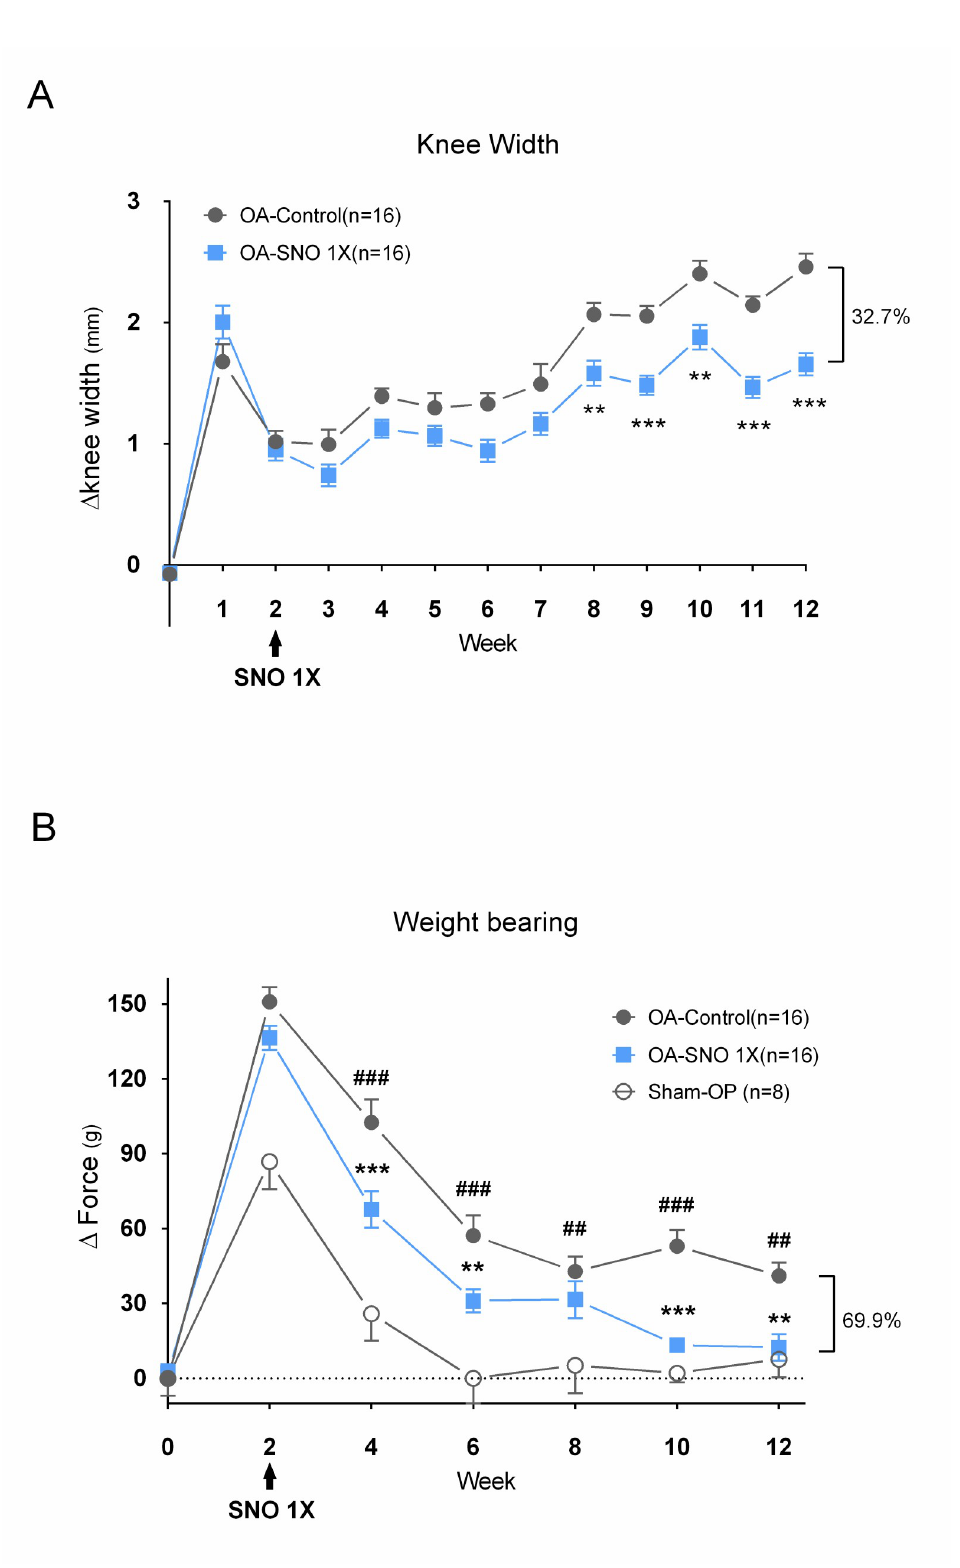
Fig 2. Oral SheaFlex75 administration reduces acute OA-induced knee joint swelling and restores the hind paw weight-bearing imbalance. ACLT+MMx was performed to induce knee OA. Two weeks later, the rats were